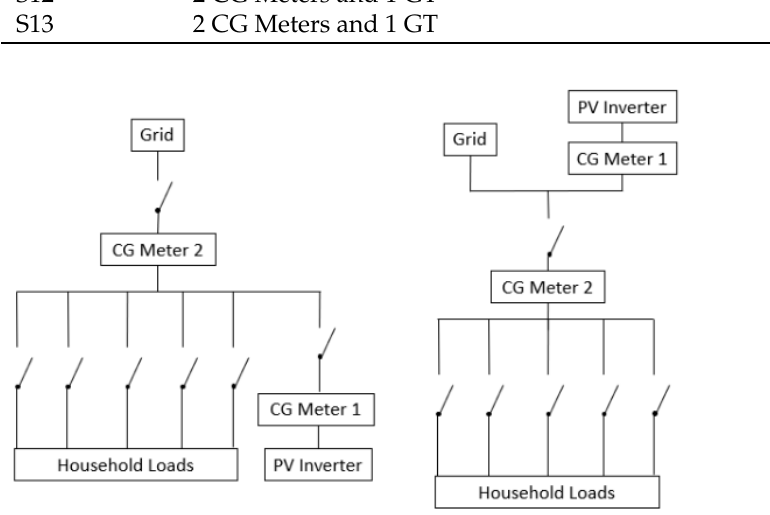
Figure 6. Typologies of the self-consumption facilities encountered during the